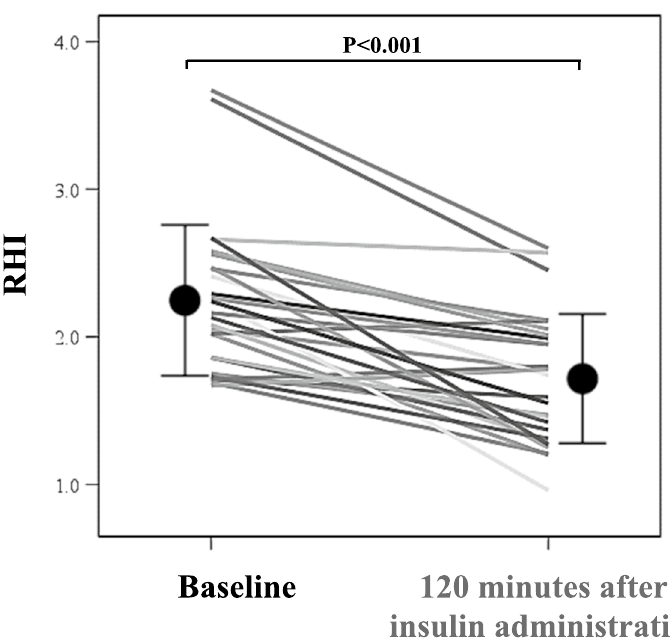
Figure 2. Changes in RHI during the insulin tolerance test. Circles: mean ± standard deviation. P < 0.001 vs. baseline, by Wilcoxon signed-rank test. RHI, reactive hyperemia index.